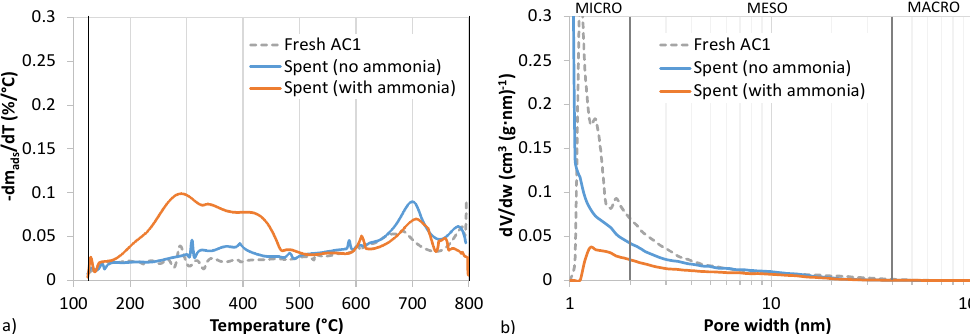
Figure 7. Characterization of fresh and spent AC1 from experiments with and without ammonia in syngas as presented in Figure 5b. ( a ) Thermogravimetric analysis (TGA) in N 2 . Percentage weight change derivative (weight loss) as a function of temperature. ( b ) Pore volume change as a function of pore width.